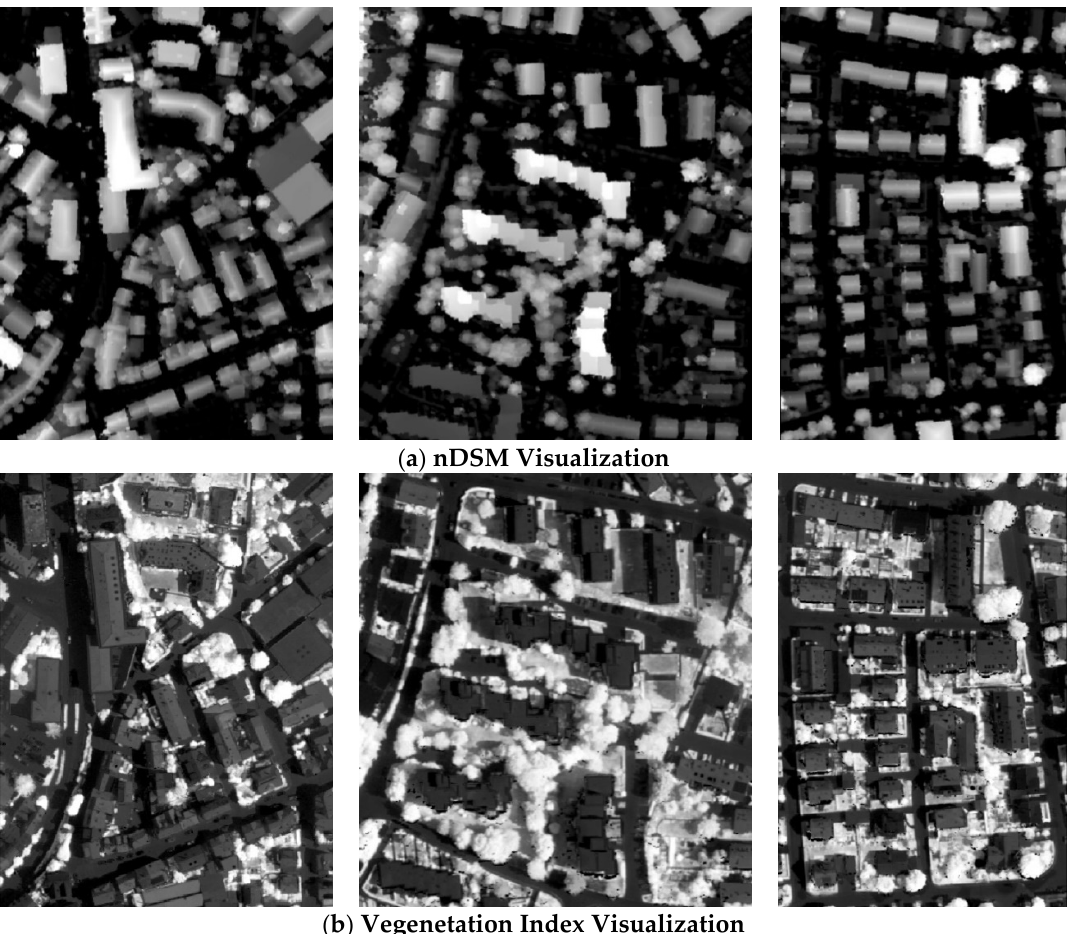
Figure 4. Visualization of the height and vegetation index for the aforementioned NIR images. ( a ) The normalized nDSM values to measure the height. ( b ) Visualization of the vegetation index as defined in Equation